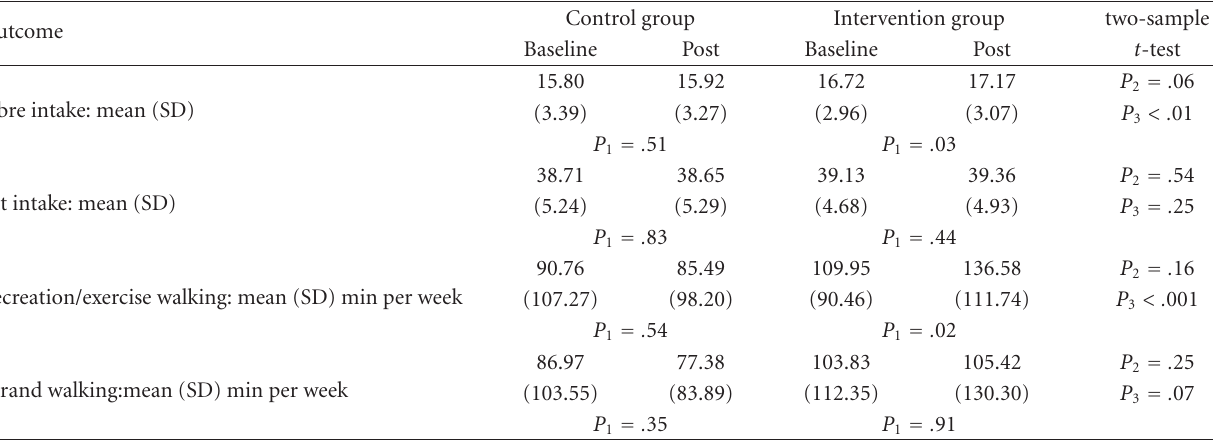
Table 2: Comparison of outcomes between PANS participants and controls.